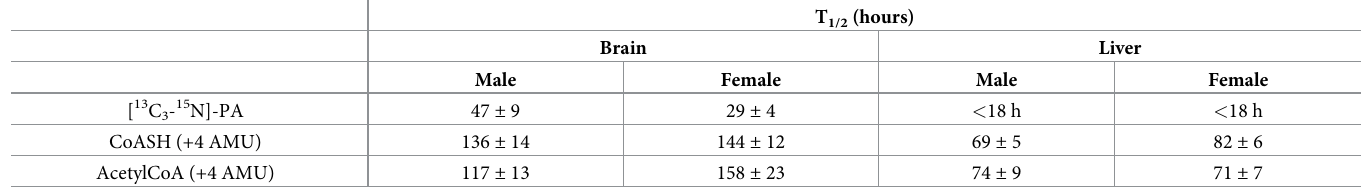
Table 4. Summary of [ 13 C 3 - 15 N]-pantothenic acid ([ 13 C 3 - 15 N]-PA), free CoA (CoASH) (+4 AMU) and acetylCoA (+4 AMU) half-life in male and female C57BL/6N mouse brain and liver.